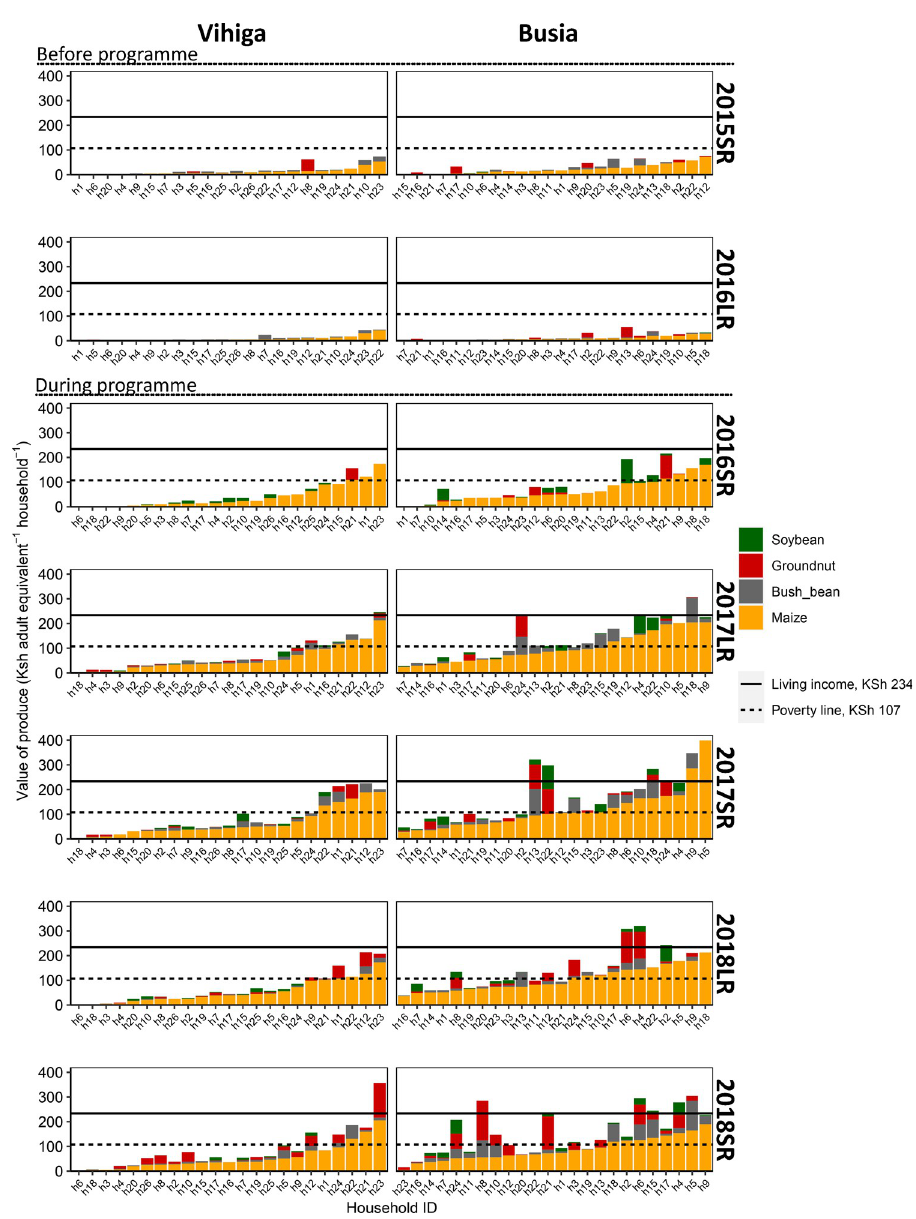
Fig 2. Value of produce in Kenyan Shilling (KSh) per adult equivalent per day for each household. Households were ordered each season based on their value of produce of maize. Household ID’s were assigned per location. Seasons 2015SR and 2016LR were before the programme (farmer-reported production), seasons 2016SR, 2017LR, 2017SR, 2018LR and 2018SR were during the programme with the voucher available (researcher measured production). SR: short rains cropping season; LR: long rains cropping season. of 3.2), which reduced the differences between the two locations when expressed per adult equivalent. Some households obtained an above average-value of produce per unit area of land. These households did not necessarily obtain greater yields but planted almost their whole farm with the four crops that were part of the intervention.